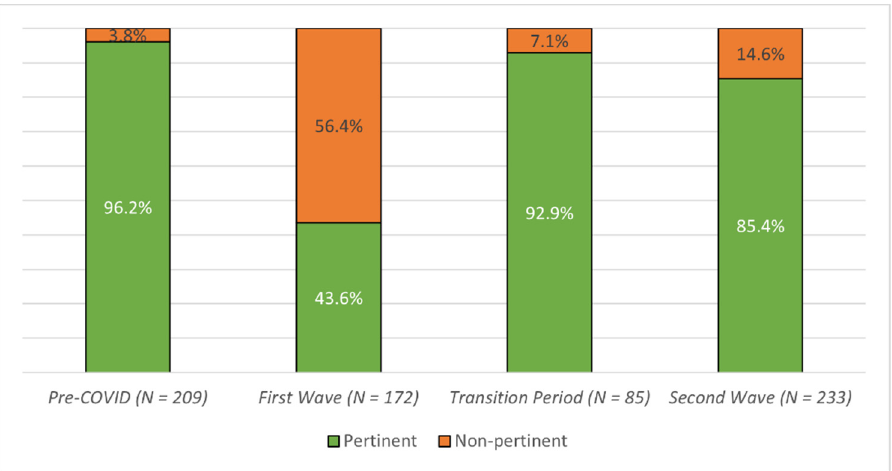
Figure 2. Proportions of pertinent gastroenterological discharge diagnoses.